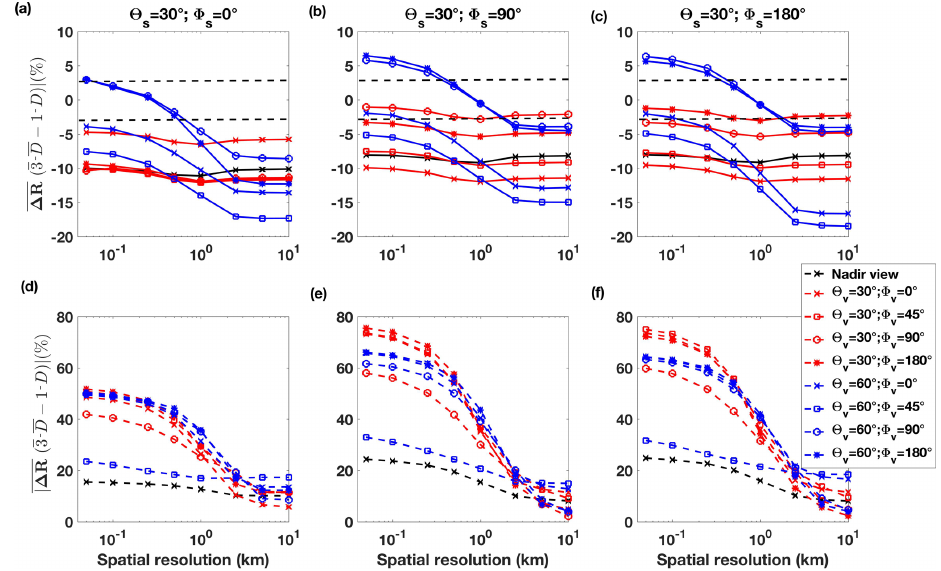
(cid:12) (cid:12) Figure 10. Mean arithmetic ( (cid:49)R ) and absolute ( (cid:12) (cid:49)R (cid:12) ) differences between 3-D and 1-D reflectances at 0 . 86µm, relative to the 3-D re- flectances in percentage, estimated with Eqs. (1) ( a , b , c ) and (2) ( d , e , f ). Each line is for a different pair of viewing zenith and azimuth angles (cid:50) v and (cid:56) v , and each panel is for a different solar azimuth angles (cid:56) s for solar zenith angle (cid:50) s = 30 ◦ . The horizontal dashed lines represent the MODIS reflectance measurement uncertainty of 3% (Xiong et al., 2005,